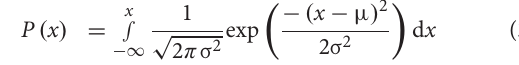
FIGURE 5 | Brain activity of visual cortices under the four Chroma conditions (/0, /2, /4, and /6) in the control experiment. Other notations are the same as in Figure 4 .